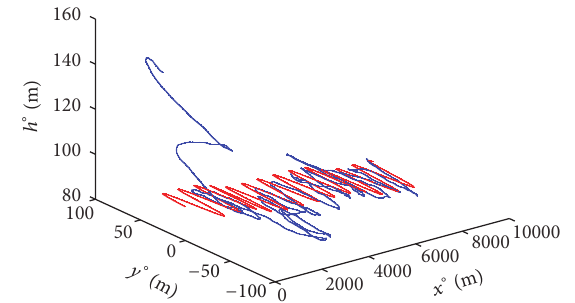
Figure 4: Three-dimensional representation of the UAV trajectory (blue line) compared with its reference (red line) trajectory.